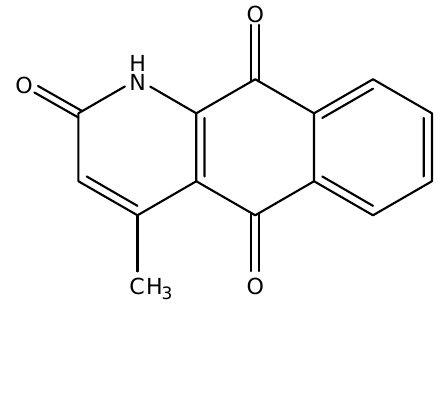
Figure 1. Chemical structure of marcanine A.